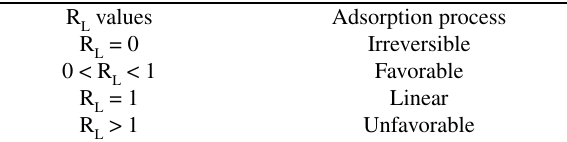
Table 3. Range of R factor. L